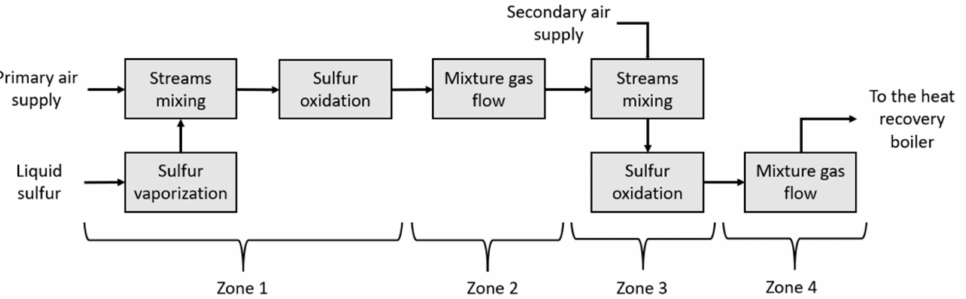
Figure 2. Reactor scheme model proposed for modeling the studied sulfur combustion